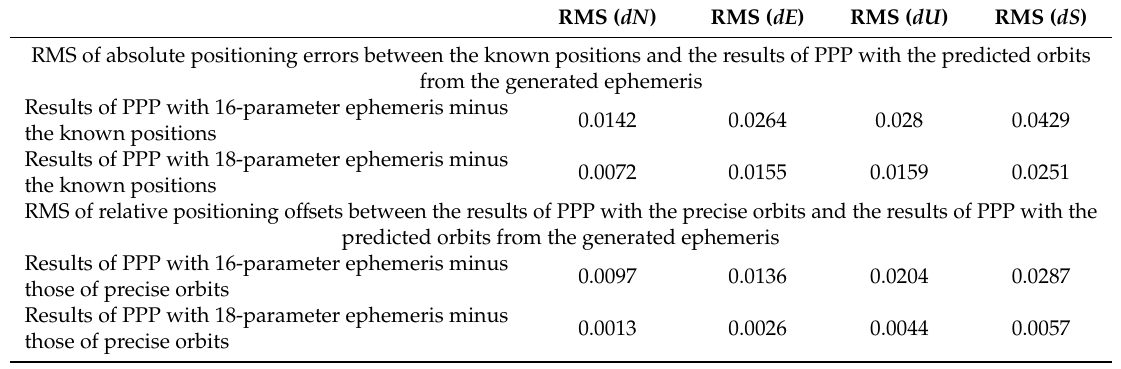
Table 4. Statistical results of the absolute positioning errors and relative positioning o ff sets with the generated ephemeris predicting of 15 min orbits after the 2 h validity